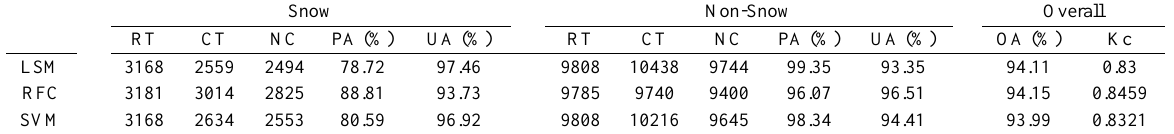
Table 2 . Accuracy assessment of Linear Spectral Missing (LSM), Random Forest Classifier (RFC), and Support Vector Machine